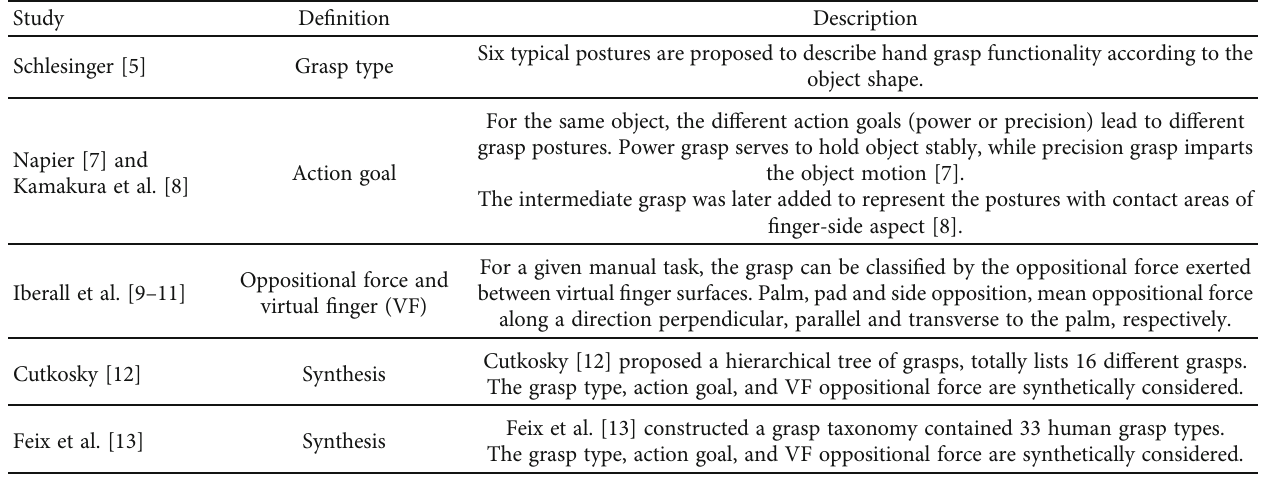
Table 1: Summary of selected precious studies on grasp classi fi cation.